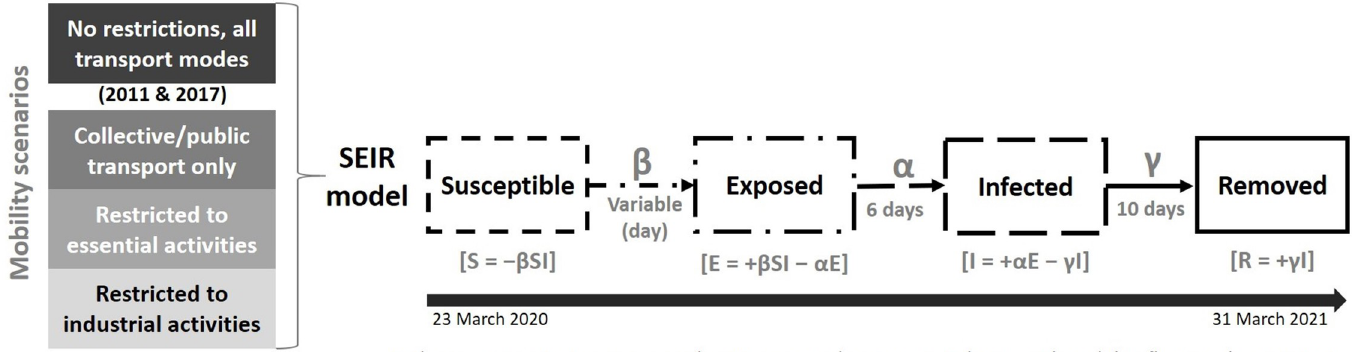
Fig 4. Schematic representation of the simulation procedure